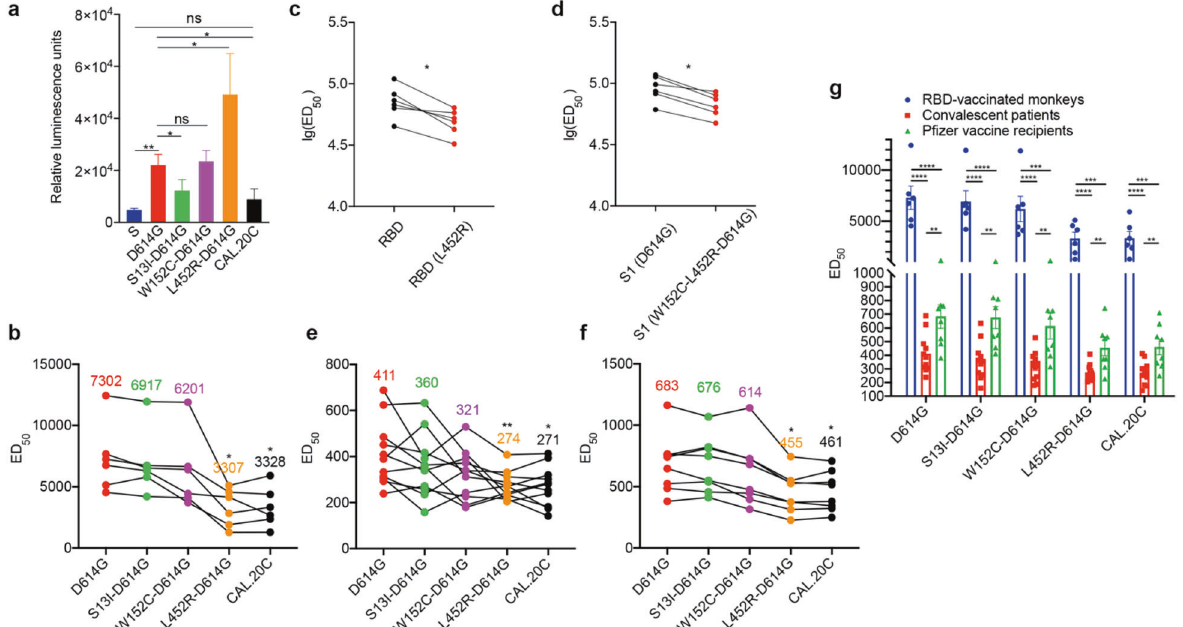
Fig. 1 Infectivity and neutralizing activities of immune sera for CAL.20C variants. a Infectivity levels with a pseudotyped virus. X -axis shows different COVID-19 S variants and Y -axis shows relative luminescence unit determined by infectivity assay (compared to the cell culture control). b Comparison between the binding af fi nity of RBD and RBD (L452R) with immune sera from nonhuman primates by ELISA ( n = 6). c Comparison between the binding af fi nity of S1 (D614G) and S1 (W152C-L452R-D614G) with immune sera from nonhuman primates by ELISA ( n = 6). d Neutralization activities of the immune sera from nonhuman primates vaccinated with an RBD protein vaccine ( n = 6). e Neutralization activities of sera from COVID-19 infection convalescent patients against various pseudotyped viruses expressing COVID-19 S variants related to CAL.20C ( n = 11). f Neutralization activities of sera from vaccine recipients ( n = 8, P fi zer-BioNTech) against various pseudotyped viruses expressing COVID-19 S variants related to CAL.20C. g Cross-comparison of neutralization activities of sera from the RBD- vaccinated monkeys ( n = 6), COVID-19 convalescent patients ( n = 11), and mRNA vaccine recipients ( n = 8, P fi zer-BioNTech) against various pseudotyped viruses expressing COVID-19 S variants related to CAL.20C. In b – g , X -axis shows different COVID-19 S variants and Y -axis shows ED 50 or lg(ED 50 ), values of serial dilution for 50% effective neutralization. n.s. nonsigni fi cant. * P < 0.05, ** P < 0.01, *** P < 0.001, and **** P <